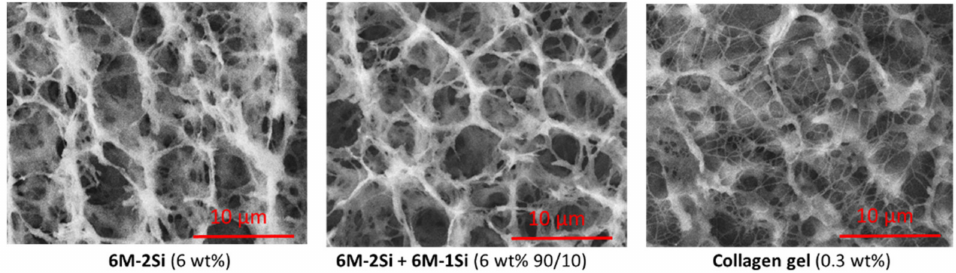
Figure 4. Cryo-SEM images of hydrogels obtained at 37 ◦ C in DPBS at pH 7.4 for 24